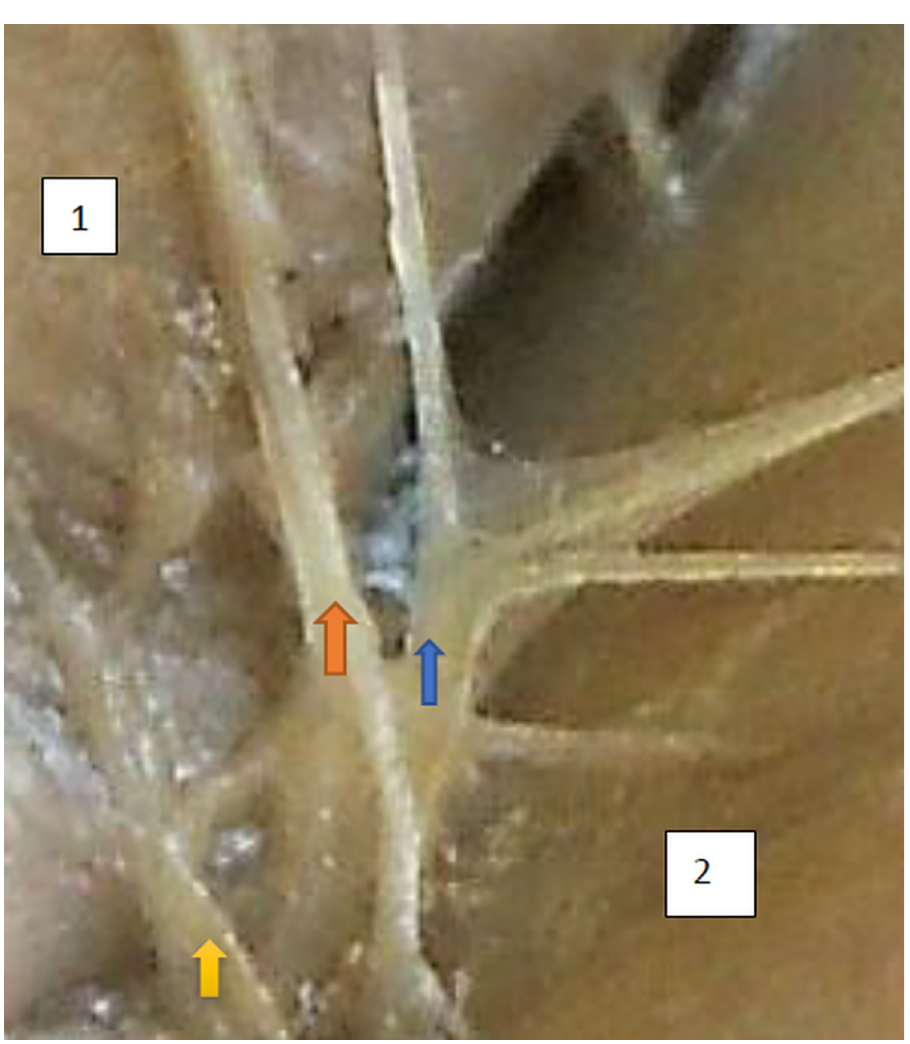
Fig 8. Superior gluteal nerve bushy type, vertical course, morphological age 157–23–VI, v–tub182, v–pl 258, mass 450, female sex, magnification 20x, 1– gluteus medius muscle, 2– gluteus minimus muscle, red arrow–branch to gluteus medius muscle, yellow arrow–branch to gluteus minimus muscle, blue arrow–branch to tensor fasiae latae